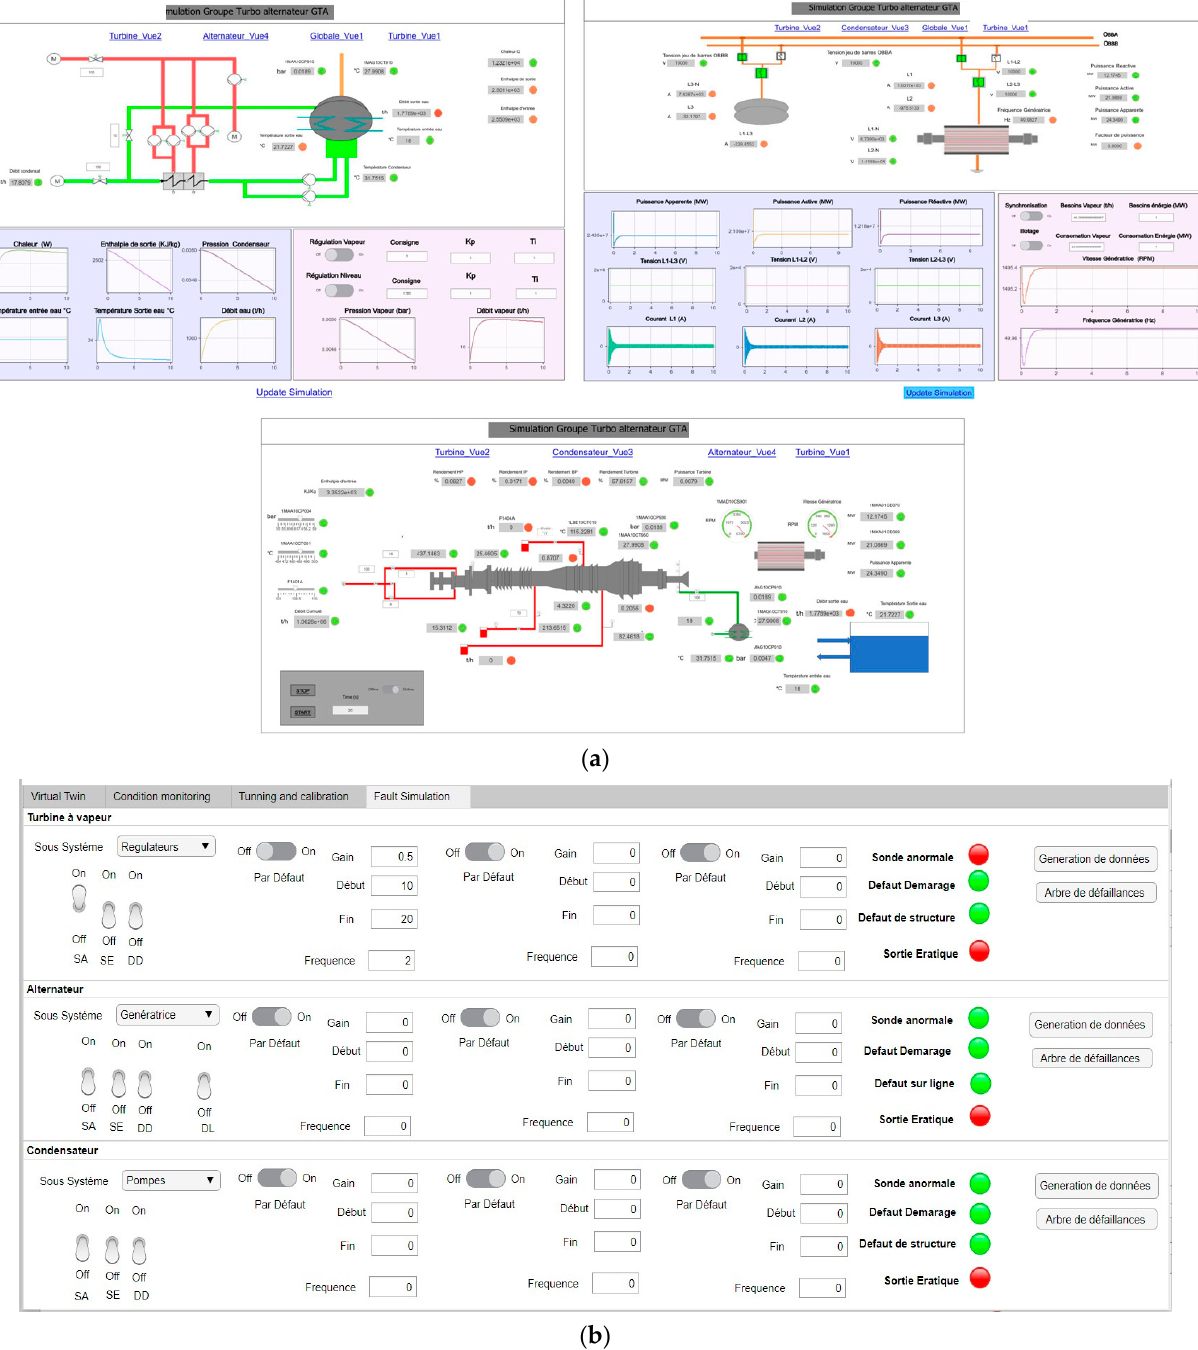
Figure 21. Virtual twin GUI for steam turbine, condenser and electrical generator condition monitoring ( a ). Fault simulation interface for synthetic data generation ( b ).